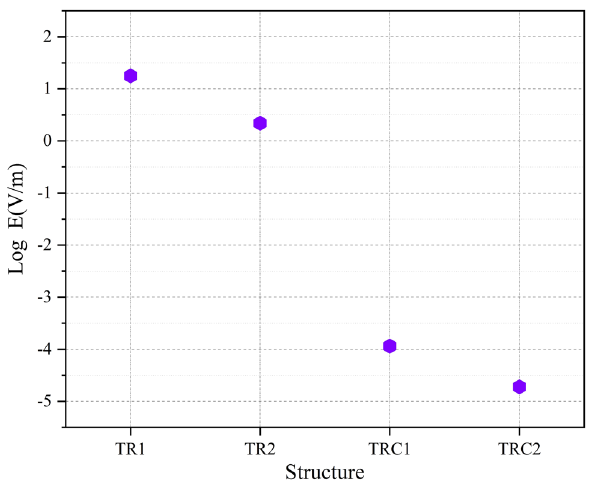
Figure 14. Comparison of electric field at the end of the tube in different structures of plasma jet nozzles.